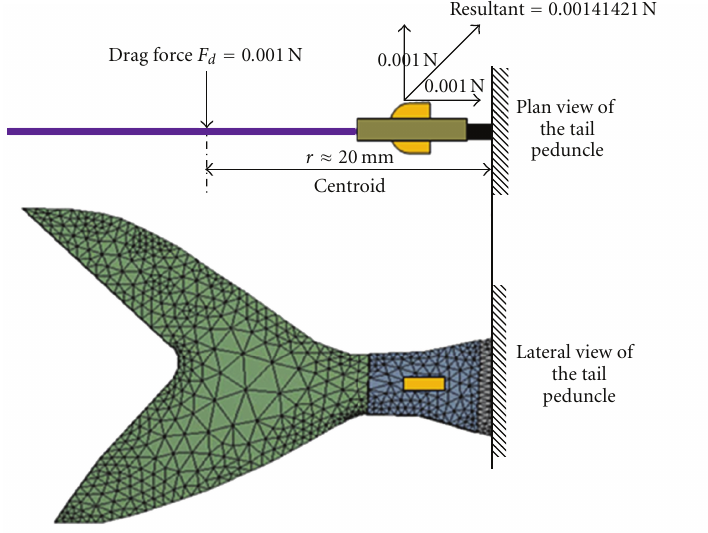
Figure 21: Simulated input loads—plan and side views. The finite element tool determines the centroid of the area.